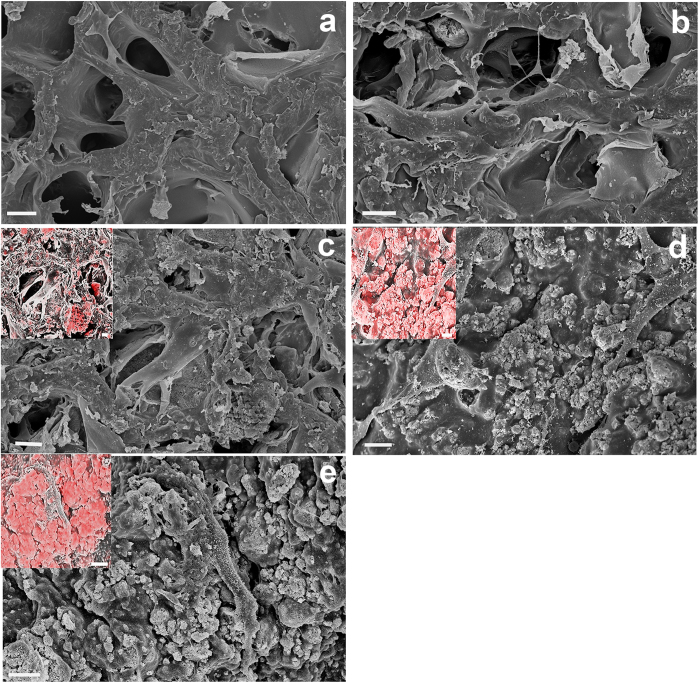
SEM micrographs of PDPCs cultured for 7 days on the different HA/Gel scaffolds. (a) 0/100; (b) 10/90; (c) 25/75; (d) 60/40; (e) 70/30. Inserts show SEM/EDX mapping of the different distribution of Ca2+ ions (red) in 25/75, 60/40 and 70/30 HA/Gel scaffolds. SEM/EDX mapping for 0/100 and 10/90 HA/Gel samples was not achieved due to the absence or the very low concentration of HA, respectively. Scale bars 10 μm.